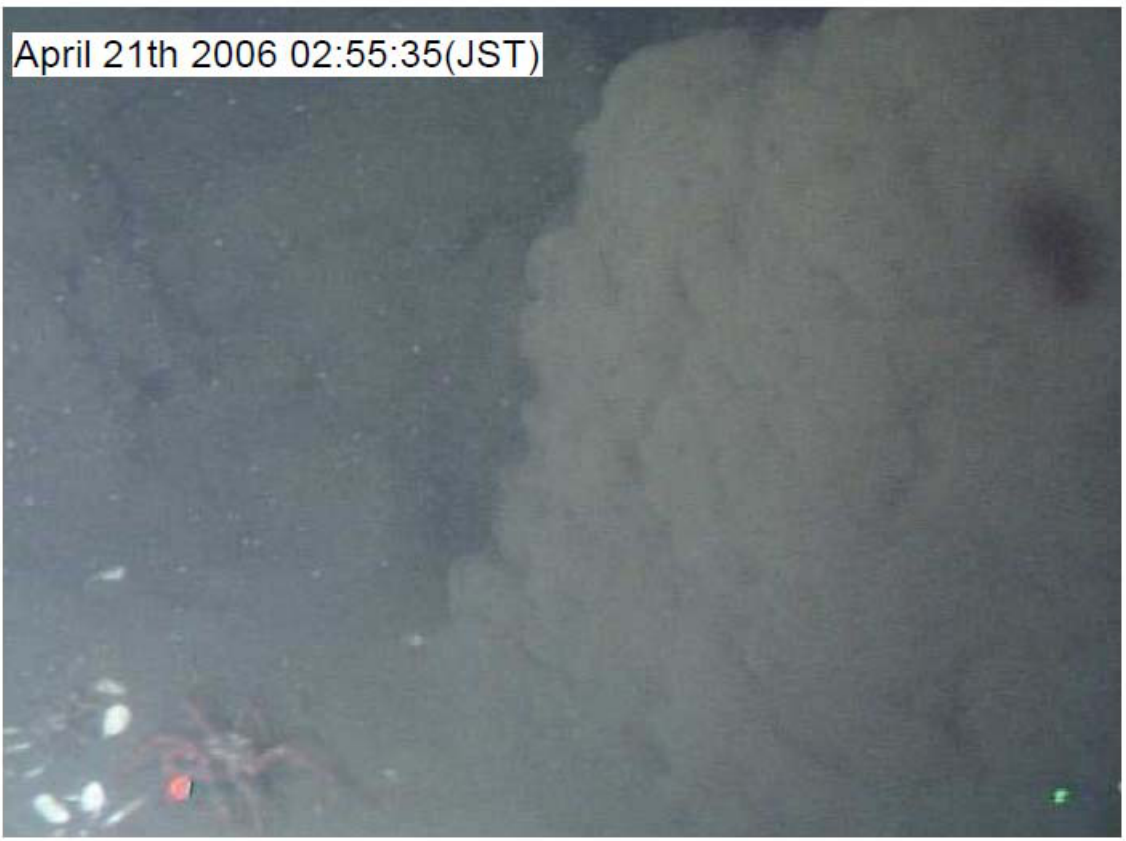
Figure 7. Captured image of the mudflow at 2:55 taken using the SuperHARP